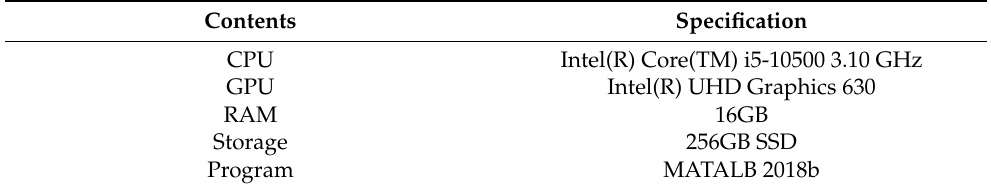
Table 12. Specifications of computer.